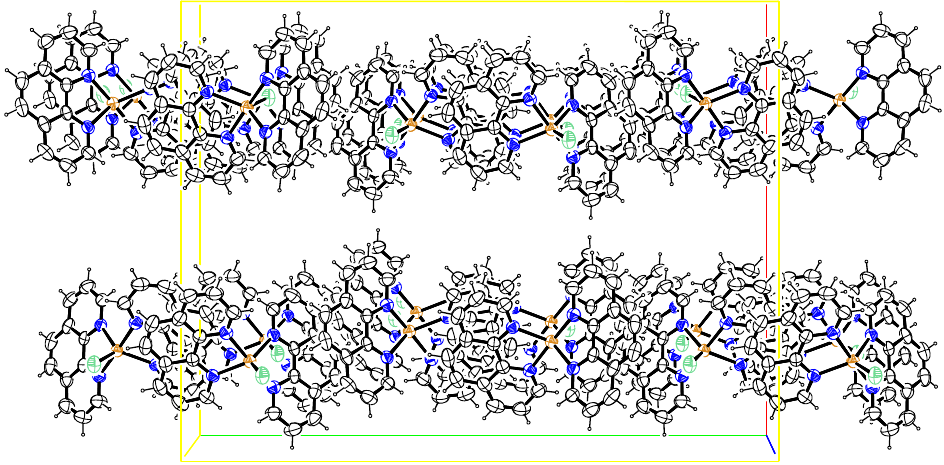
Figure 2. Crystal packing diagram drawn normal to (001). Ellipsoids are drawn at the 50% probability level for the photocatalyst. Table 3. Selective hydrogen-bond, Y—X··· π ring, and π ··· π stacking interactions for the crystal structure of [Cu(phen) 2 Cl].